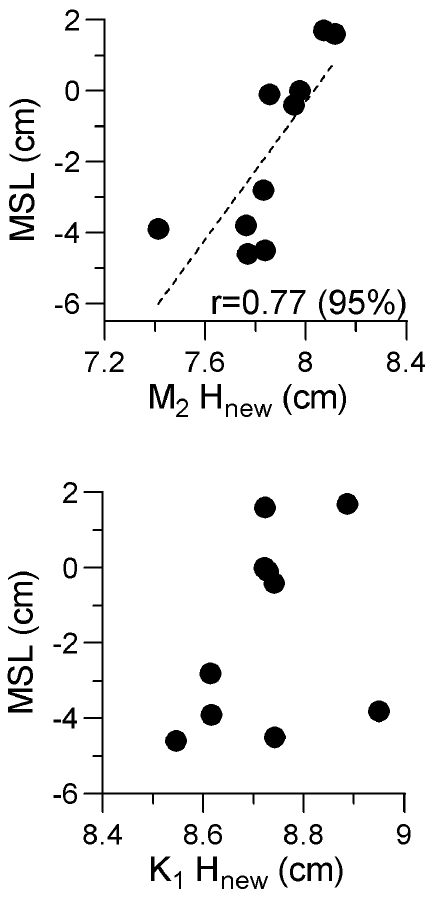
Fig. 5. Regression diagrams between MSL and the M 2 and K 1 am- plitudes (H new ) obtained by the AutoCAD software between 1986 and